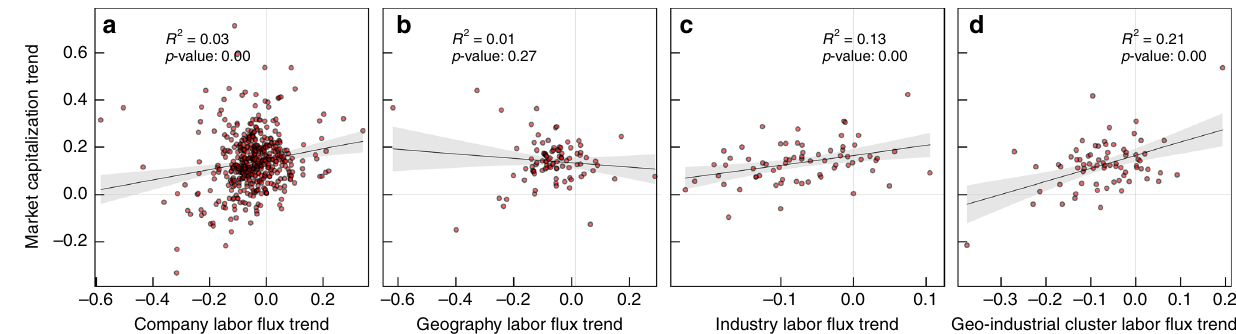
Fig. 4 The in fl ux of educated labor force is linked to the growth of geo-industrial clusters. The horizontal axis represents the 5-year trend in college-degree labor fl ux from 2010 to 2014. Similarly, the vertical axis represents the 5-year trend in log-scaled market capitalization within the cluster over time. a The trends for individual fi rms. b The trends for geographical regions. c The trends for industries, and d the trends for geo-industrial clusters, which displays